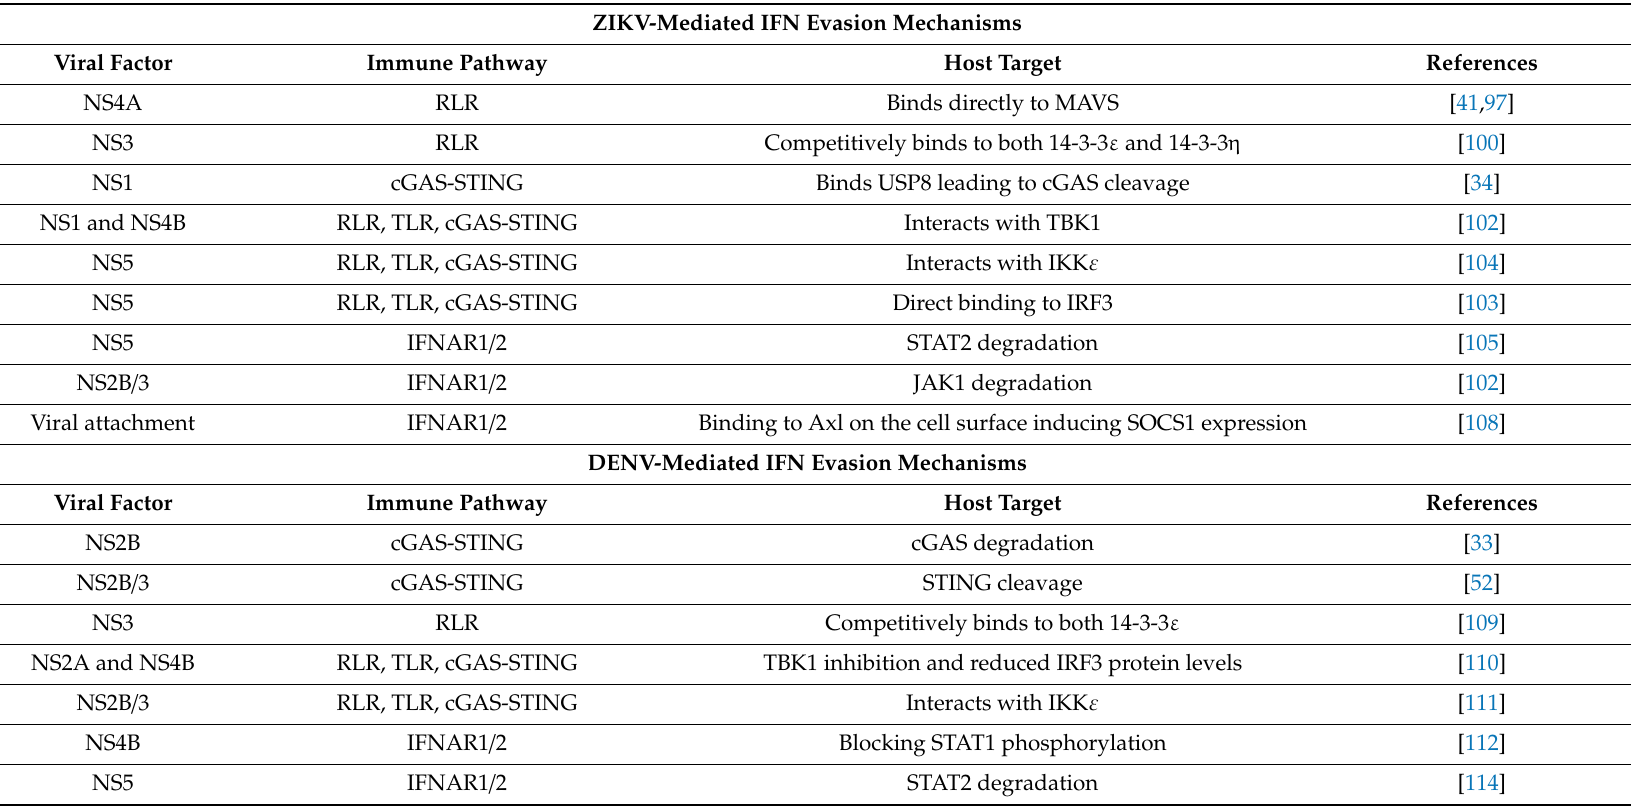
Table 1. Summary of virus specific IFN evasion mechanisms for both ZIKV and